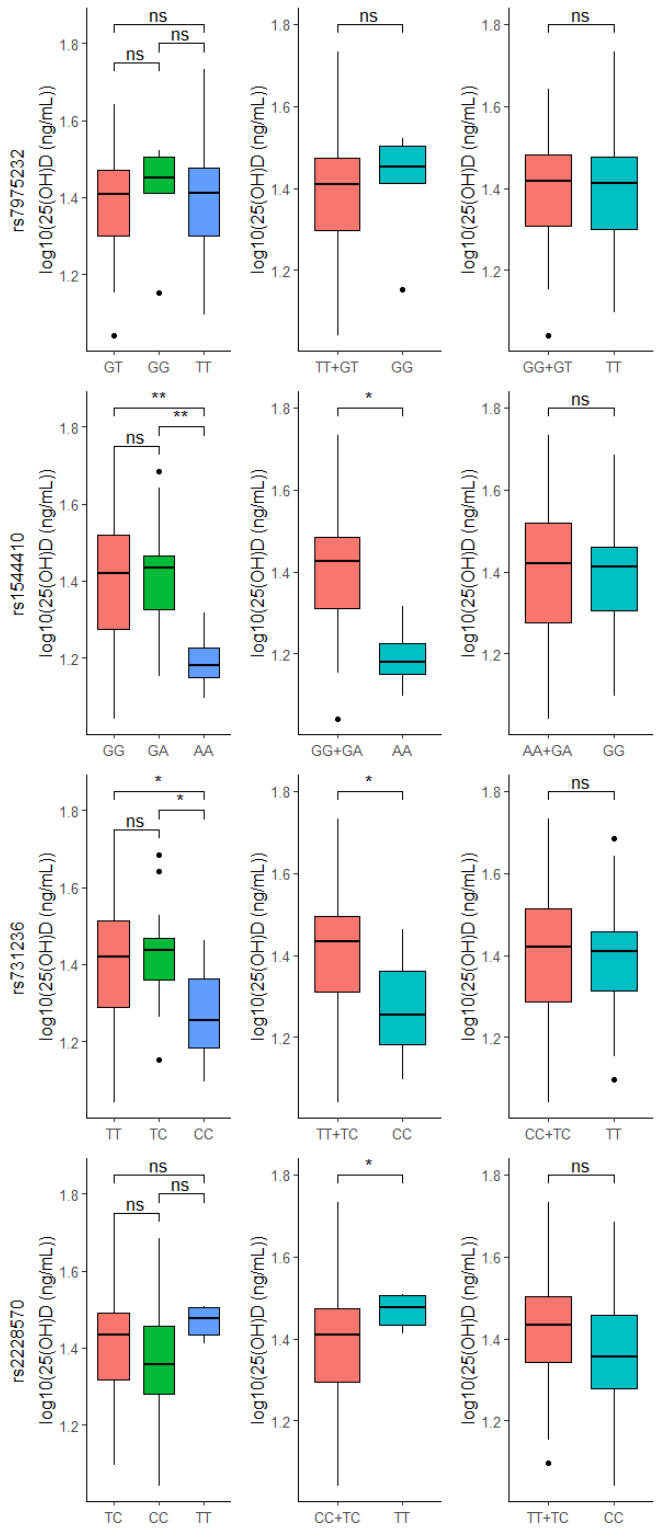
Figure 4. Comparison between 25(OH)D levels and VDR genotypes within T1DM group. ns: p > 0.05, * p < 0.05, ** p < 0.01.